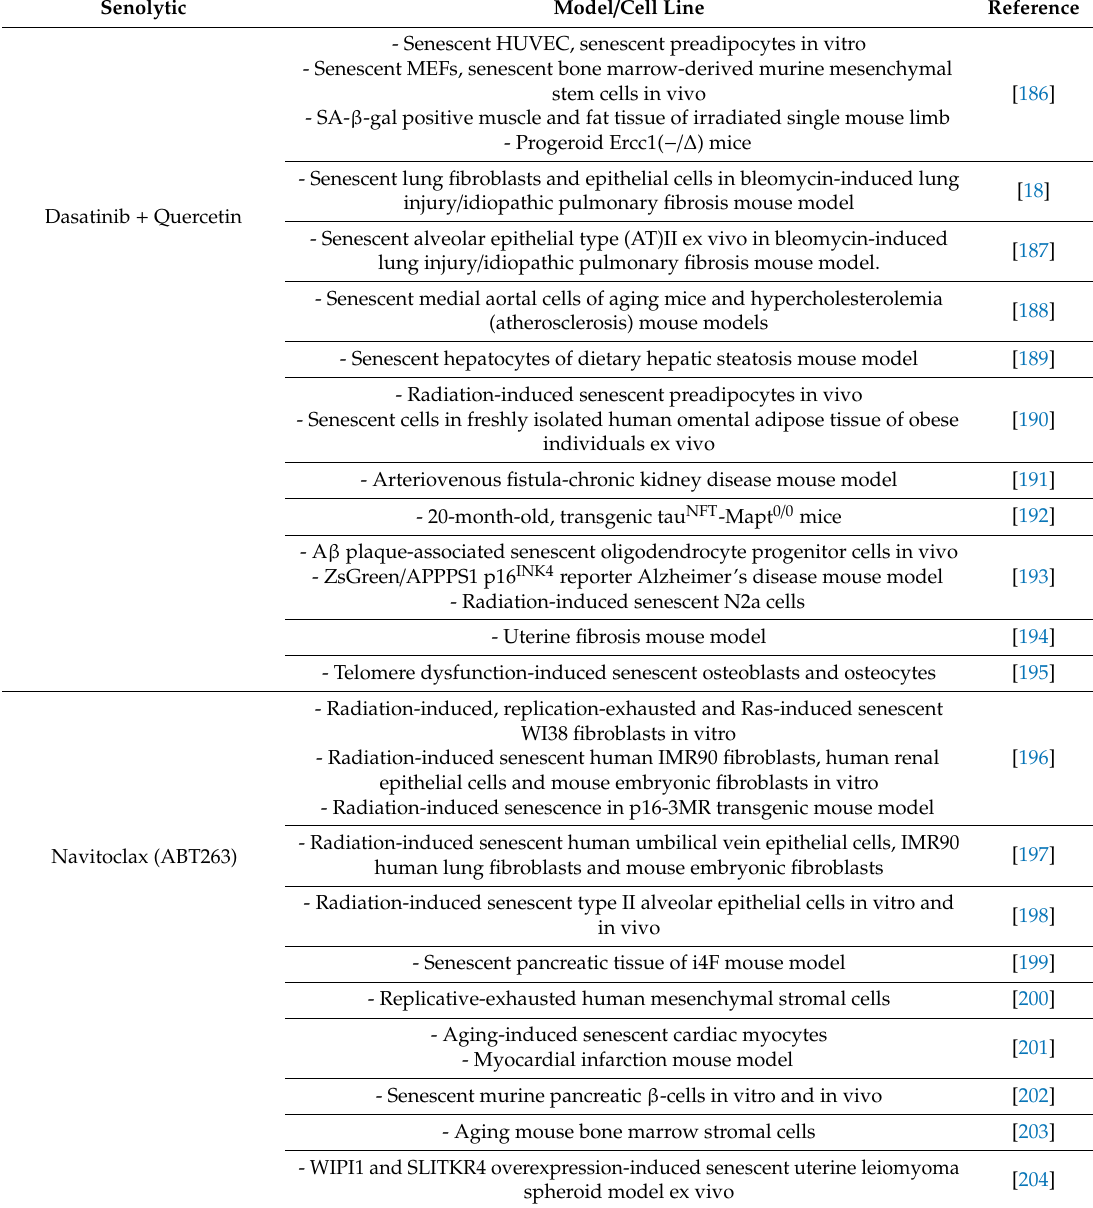
Table 2. Summary of preclinical evidence on the available senolytic